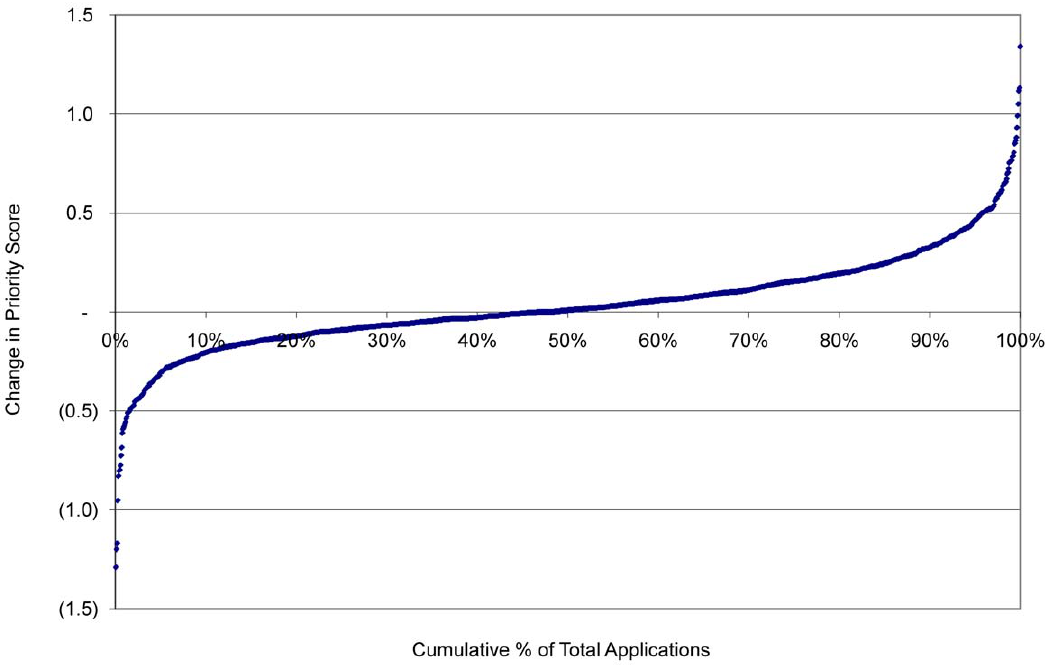
Figure 2. Effects of SRG Meeting Discussion on Final Priority Score. Applications were rank ordered by the difference between the average preliminary and final priority score of individual R01 applications and then assigned a cumulative percent value. Applications with negative values are displayed on the left and improved after discussion; those on the right were worse after discussion.